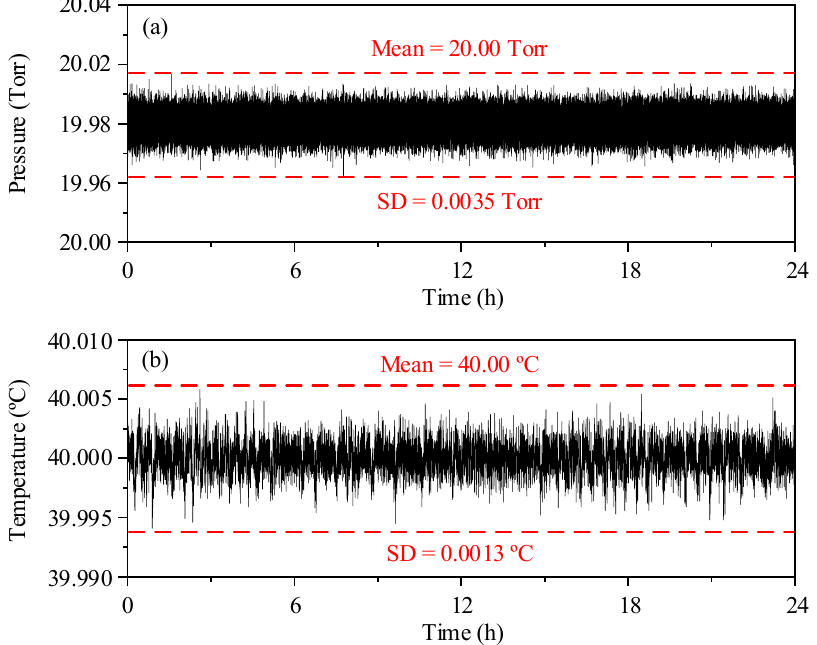
Figure 3. ( a ) Pressure in gas cell and ( b ) temperature in insulation case recorded continuously a 24 h period. According to Equation (6), theoretical temperature coefficients ∆ δ 13 C/ ∆ T = 15.0‰ K − 1 , ∆ δ 18 O/ ∆ T = 20.9‰ K − 1 , and ∆ δ 17 O/ ∆ T = 17.7‰ K − 1 are estimated at 296 K for the